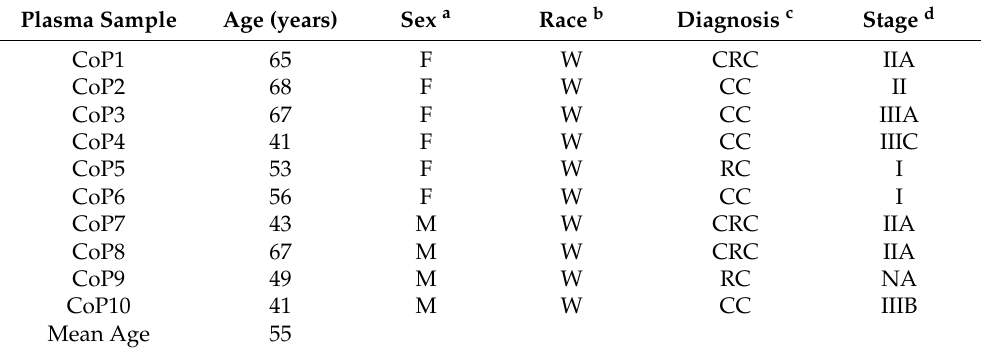
Table 4. Relative miRNA expression in immunoprecipitants of plasma small EVs from PDAC patients versus those from age- and gender-matched healthy controls and colon cancer patients. Small EVs were initially isolated from the plasma of patients with early-stage PDAC and matched colon cancer and healthy subjects. The isolated small EVs (100 µ g each) were immunoprecipitated using the magnetic-bead-conjugated antibody cocktail (antibodies against human EpCAM, CD104, c-Met, CD44v6, and TSPAN8). Total RNA was isolated from the immunoprecipitants and qRT-PCR performed for miRNA expression analysis. * p < 0.05, ** p < 0.01, one-way ANOVA (n = 10–12). Healthy Control PDAC Colon Cancer microRNA Mean ± SEM Mean ± SEM Mean ± SEM miR-18a 1.0 ± 0.09 3.05 ± 0.81 * 0.44 ± 0.06 miR-106a 1.0 ± 0.12 4.60 ± 0.79 ** 0.74 ± 0.05 miR-196-a 1.0 ± 0.25 1.59 ± 0.45 1.27 ± 0.14